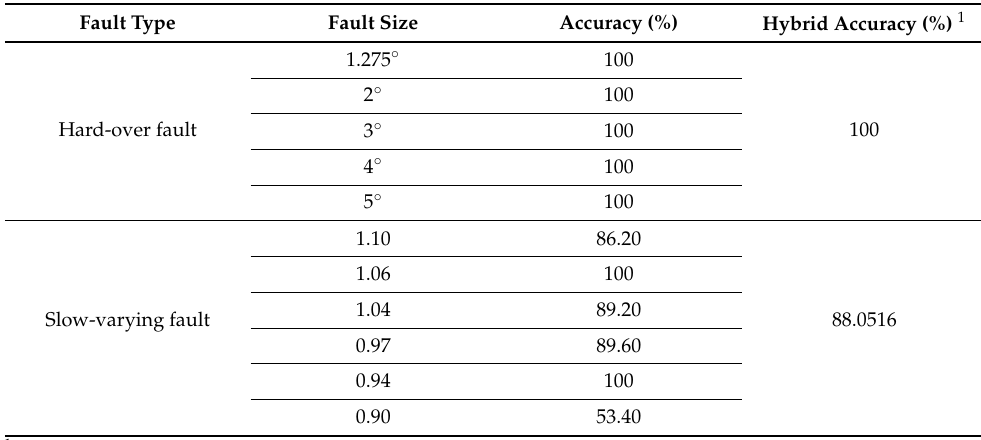
Table 3. Classification results of RF classifier for faults with different